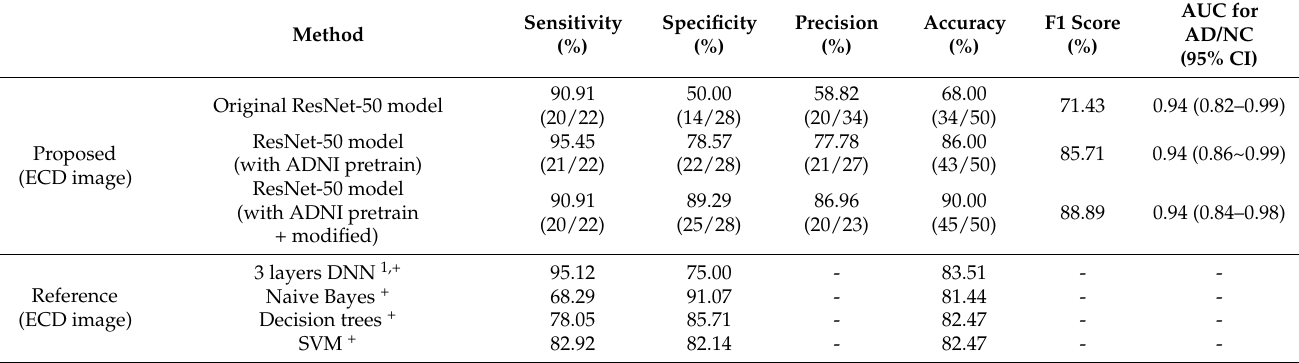
Table 4. Comparison of the training performance of ECD data sets in various models for distinguishing between AD and